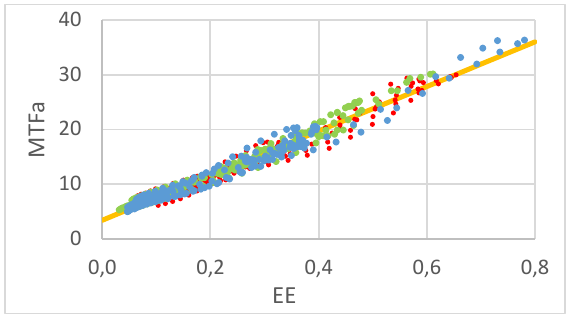
Fig. 1. MTFa vs. EE for the three MIOLs with 3mm pupil and three wavelengths (R, G, B dots). Best linear fit (yellow).